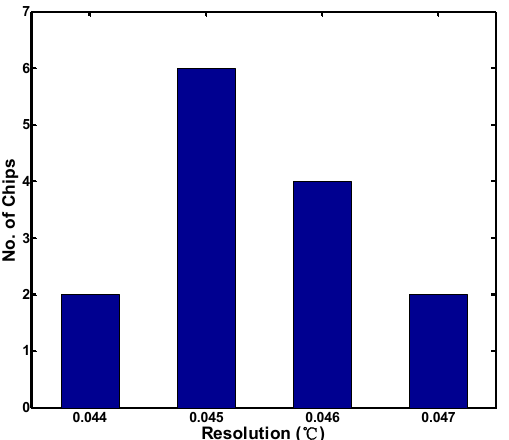
Figure 12. Resolution histogram of 14 test chips.